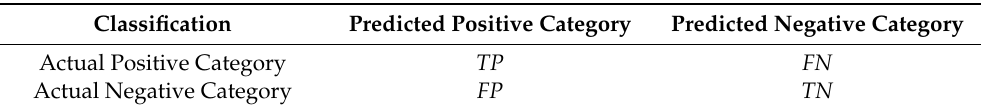
Table 6. Confusion